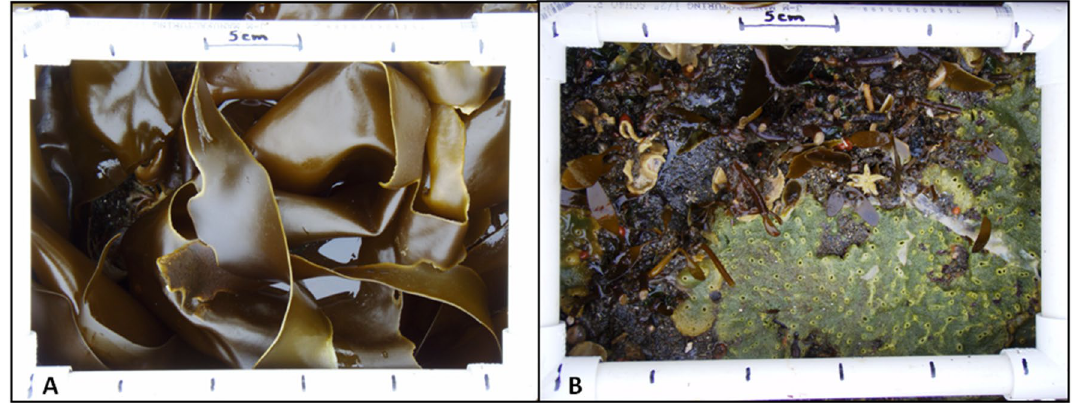
Figure 4. Example of digital photos of intertidal quadrats. A digital photo was taken first of the surface coverage of the plot ( A ). A second photo of the exact plot ( B ) was taken after the algal layer was removed to reveal the under-story community. Photos by J.